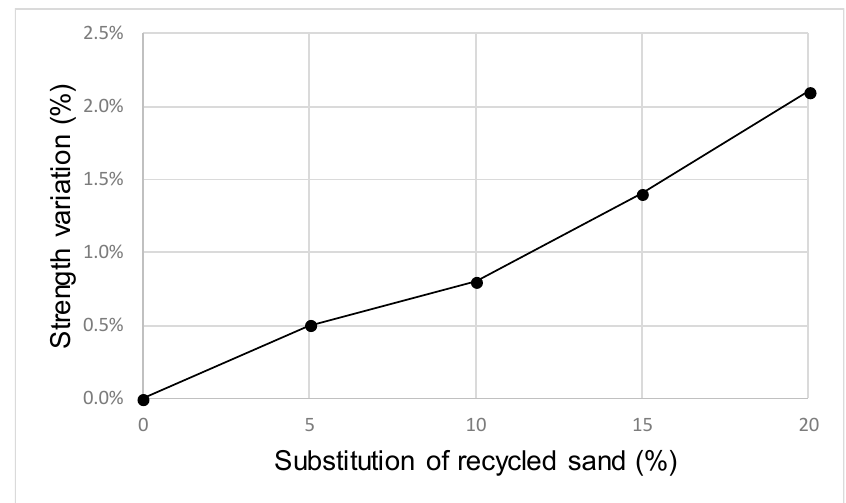
Figure 4. Variation in compression strength due to product addition.